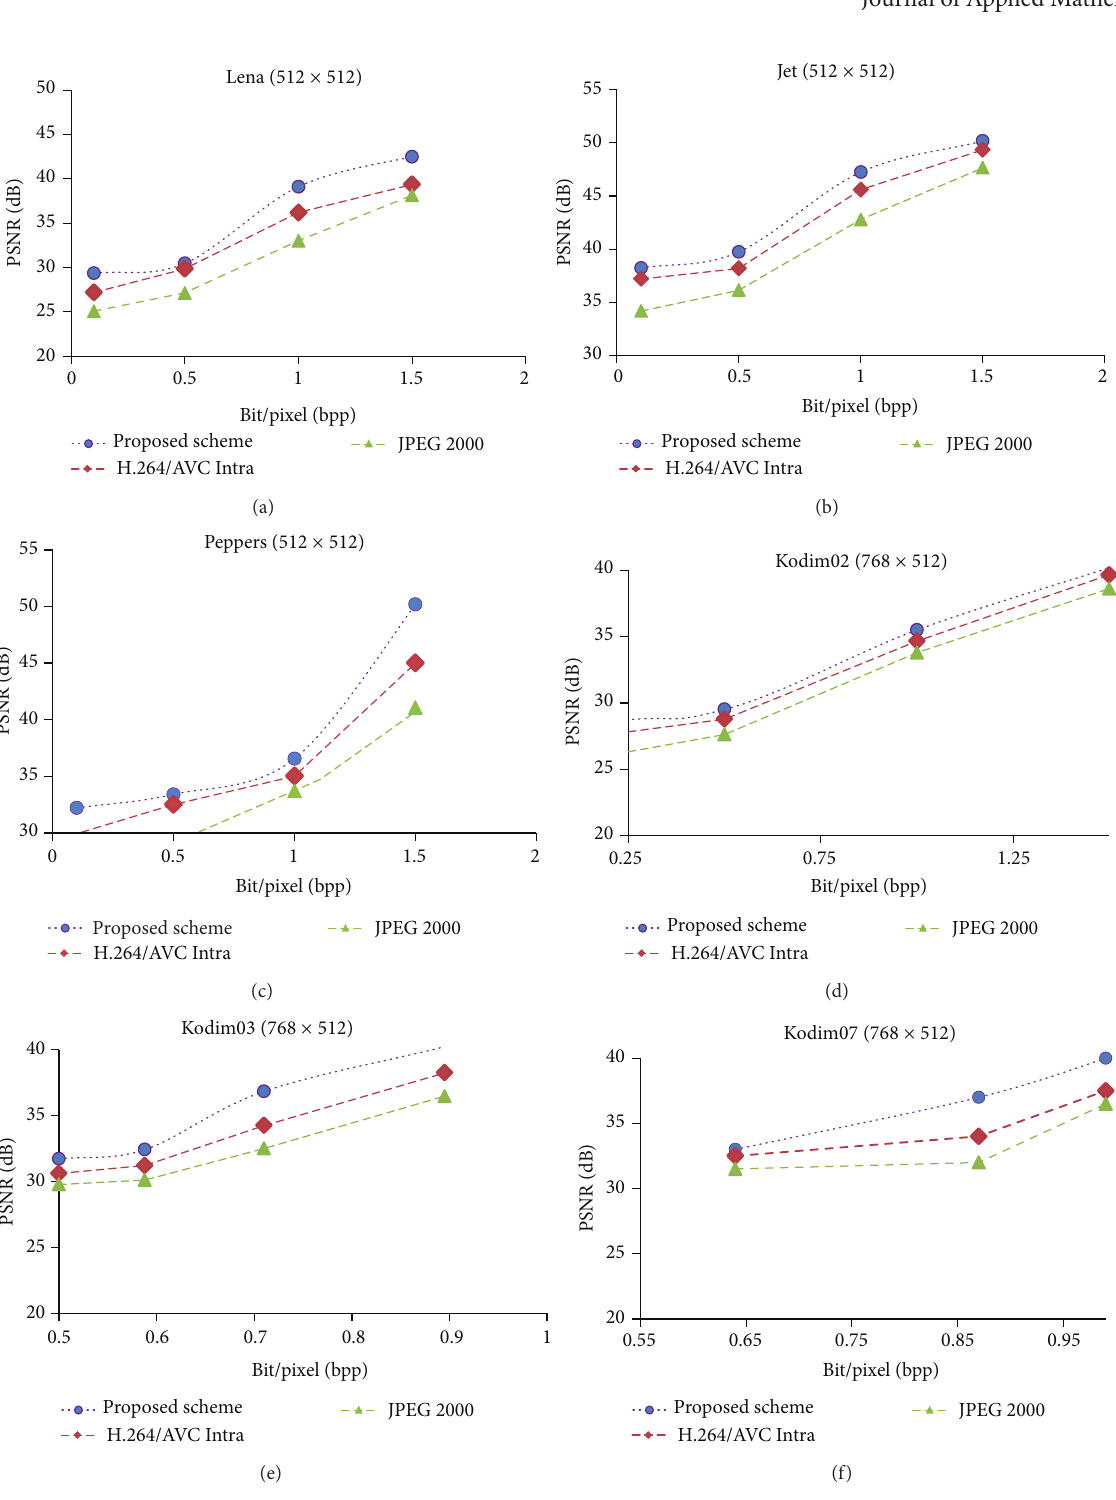
Figure 9: Objective quality comparison between proposed scheme, H.264/AVC Intra, and JPEG 2000 on some typical color